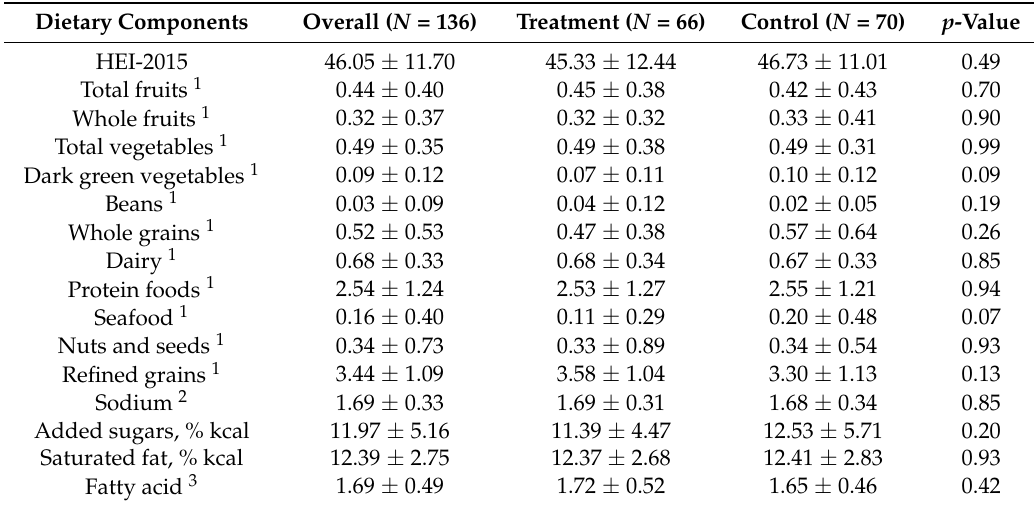
Table 2. Baseline dietary characteristics of youth with type 1 diabetes overall and by treatment assignment. Dietary